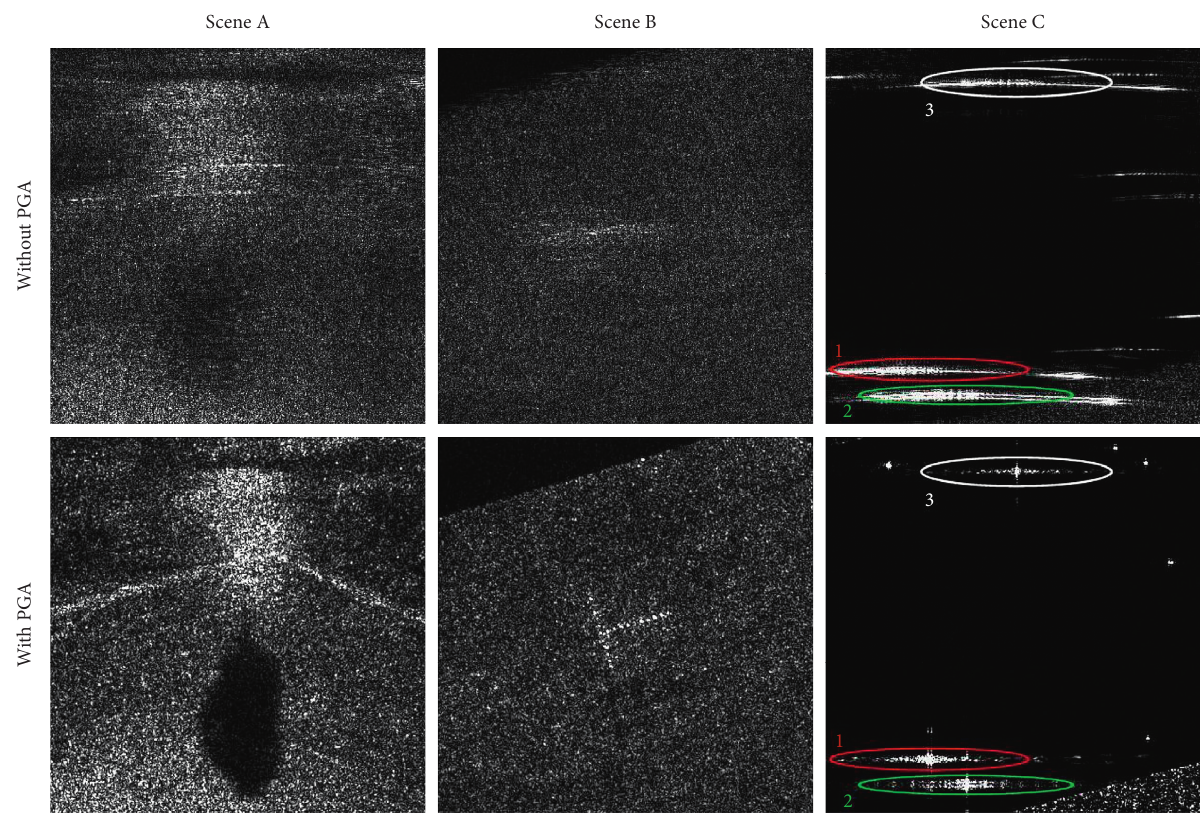
Figure 7: Magnified images of subscenes A–C in Figure 6.